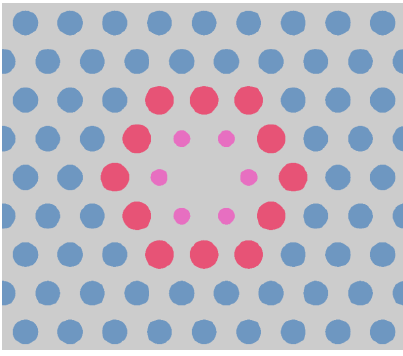
Figure 5. The close-up of the final dispersion-optimized structure. The diameters of the holes are in scale.